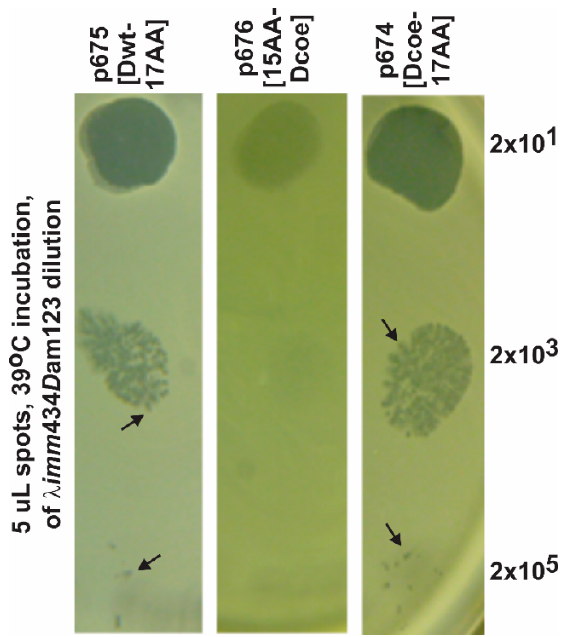
Figure 5. Complementation for phage growth by plasmid expression vectors expressing three distinct D -fusions. (Refer to Table S1 for quantitative results.) Each D -fusion construct included an 11 amino acid (GYMLGSAMSRP, termed YML) single epitope from the sequence of the cervid prion PrP protein [28].